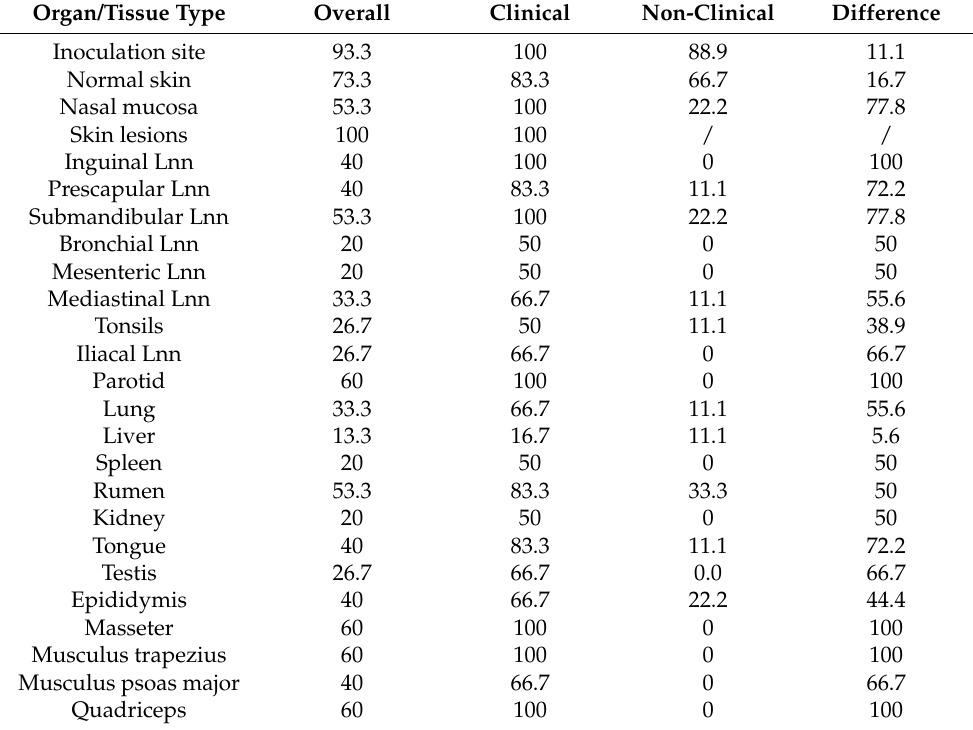
Table 2. Real-time PCR results of organ/tissue samples taken at necropsy form the control animals. The number of positive samples is expressed as percentages. Clinical: animals which developed typical LSDV skin lesions. Non-Clinical: animals without typical LSDV skin